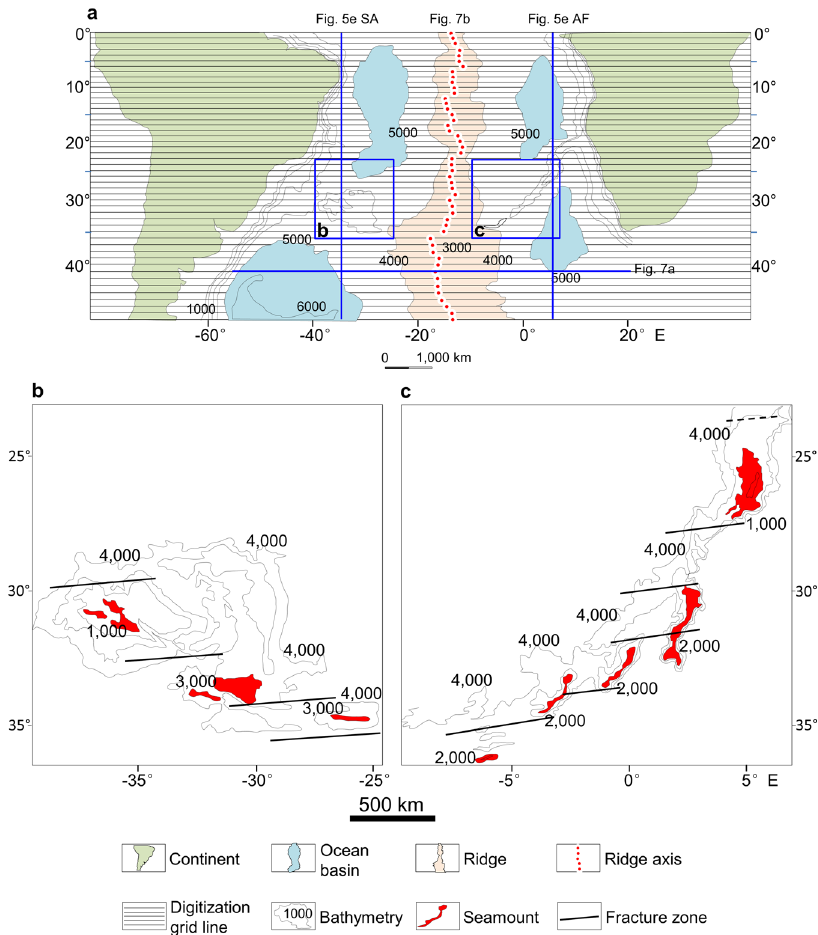
Fig. 4 Gridded contour maps for digitization of bathymetric elements in the South Atlantic 35 . a Up-scaled contour map (contour interval = 1000 m) overlaid with east-west grid lines at an interval = 1° latitude along which width and depth of bathymetric elements are digitized and plotted. Width measured along east-west gridlines carry a systematic error of − 3% to + 3% compared to the width measured along the oceanic transform faults and continental transfer faults. The digitized results are shown in Figs. 5 – 7. b Down-scaled contours of the Rio Grande Rise. c Down-scaled contours of the Walvis